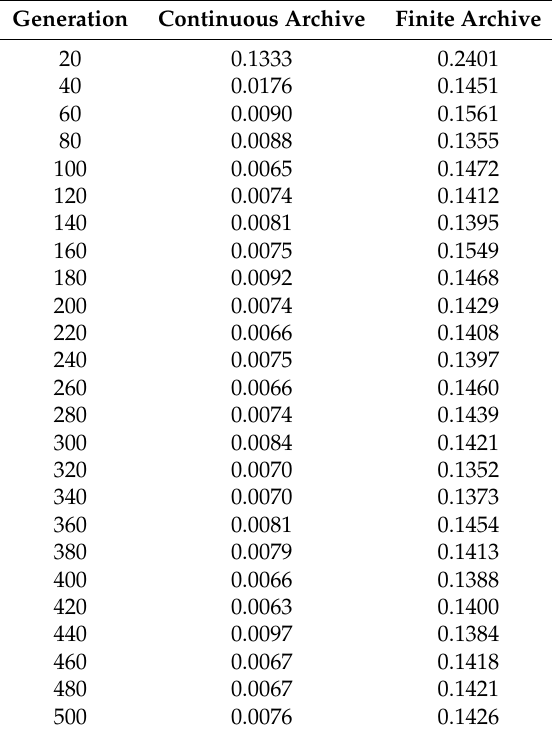
Table 6. ∆ p , q values for the discrete and continuous archives of NSGA-II for MOP (14). The results are averaged over 20 independent